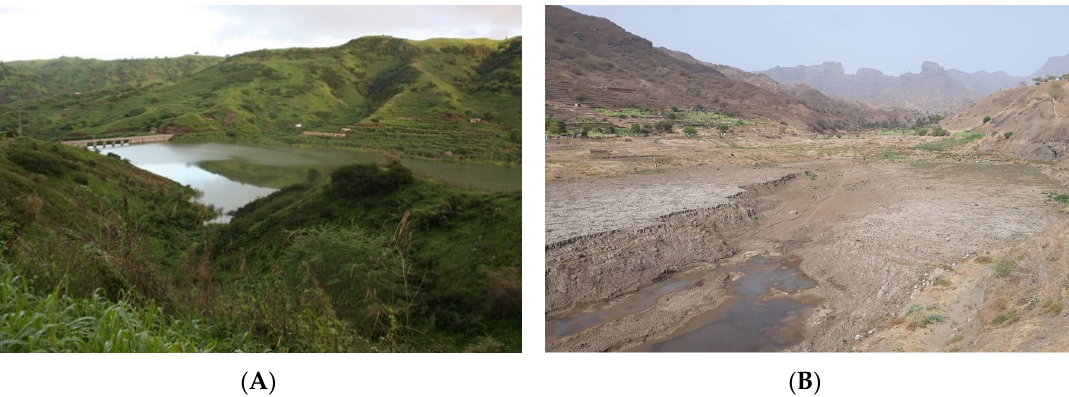
Figure 6. Poil ã o dam in S ã o Lourenço dos Ó rg ã os at the Santiago Island ( A ) Rainy season; ( B ) Dry Figure 6. Poilão dam in São Lourenço dos Órgãos at the Santiago Island ( A ) Rainy season; ( B ) Dry season). Photos taken by the authors (MMR and season). Photos taken by the authors (MMR and APE).